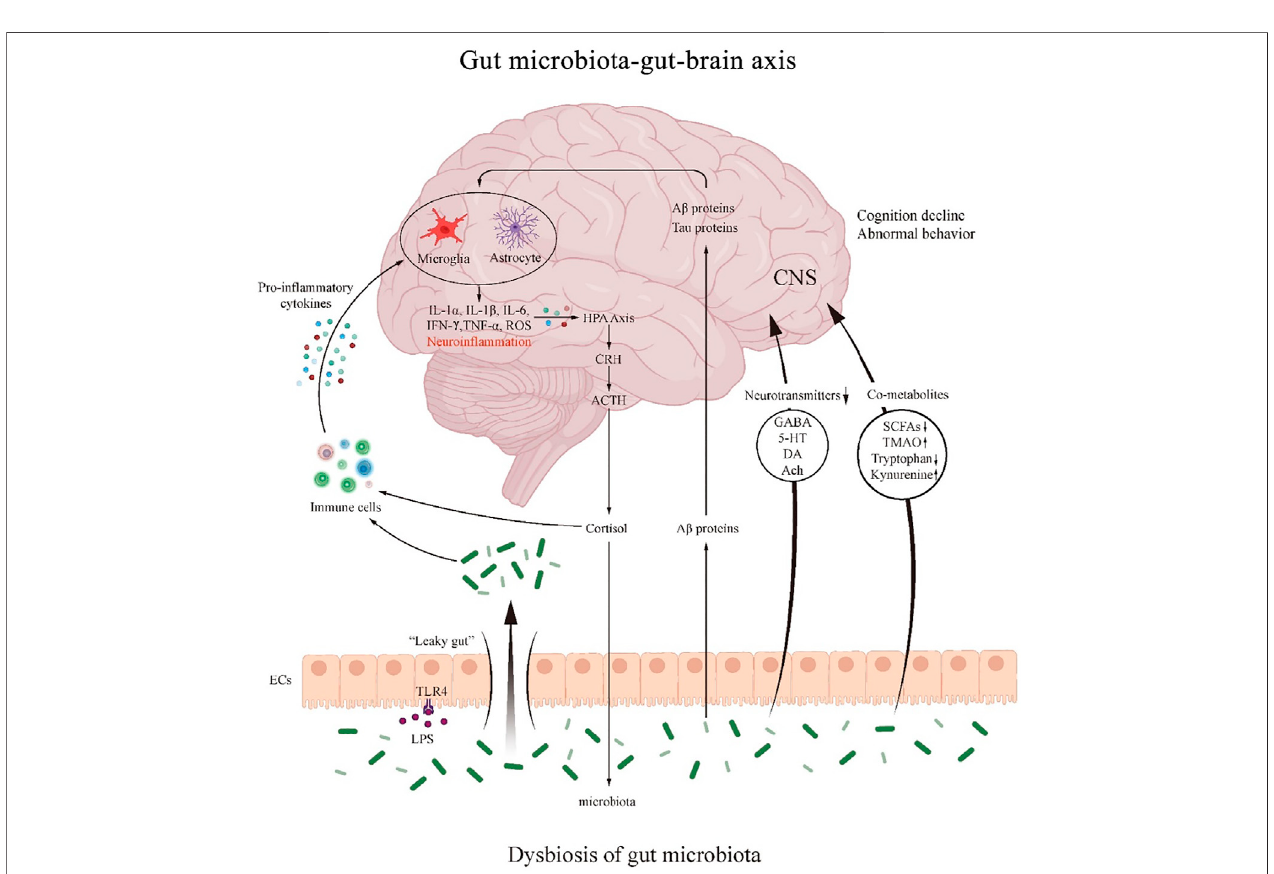
FIGURE 2 | The mechanism of the role of gut microbiota-gut-brain axis in PND. The gut microbiota regulates the interactions between the gut and brain through neural, endocrine and immune pathways. Dysbiosis of the gut microbiota regulates immune activity and produces pro-in fl ammatory cytokines that can either promote the formation of neuroin fl ammation and further activate the HPA